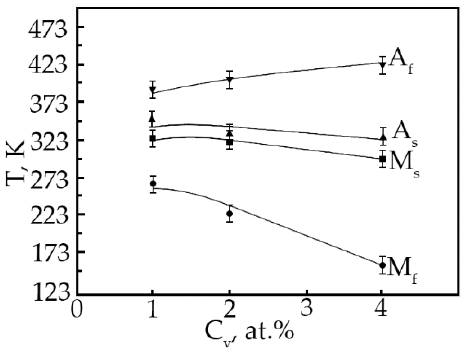
Figure 12. Concentration dependence of the characteristic MT temperatures in alloys doped with V.